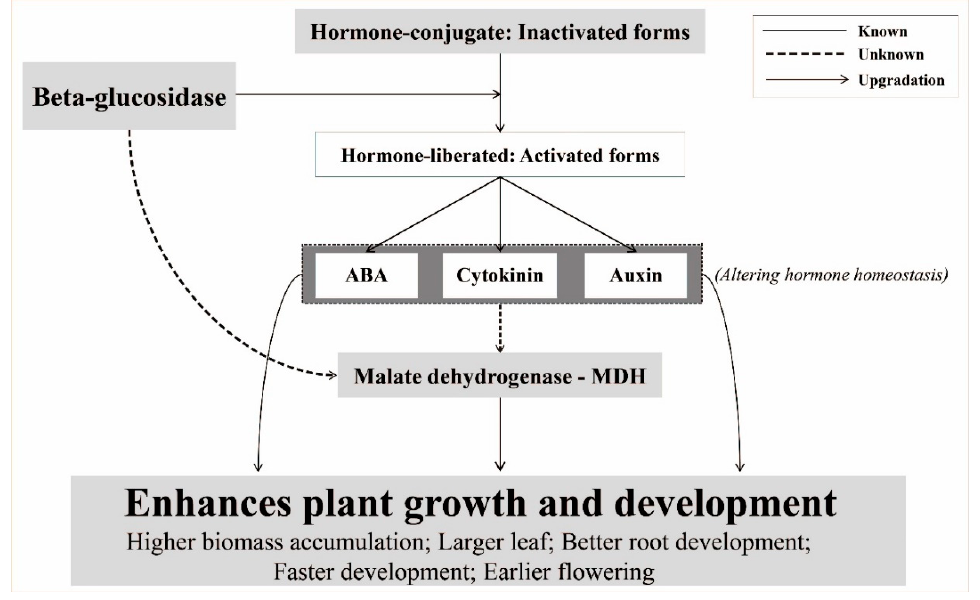
Figure 4. Hypothesis of the mechanism by which overproduced β -glucosidase enhances growth and development in transgenic